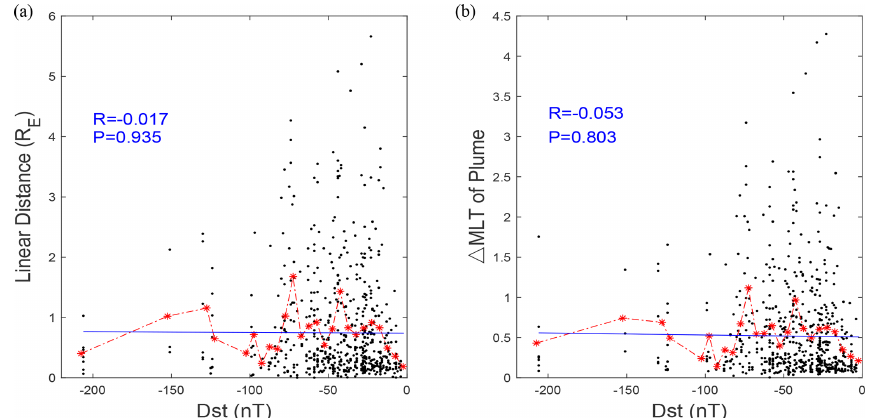
Figure 2. (a) The widths of plumes as a function of Dst values are represented by solid black dots, where the width expresses the Cartesian distance between the two ends (the entrance and exit) of the VAP-A orbit where the plume is detected. The linear fitting of the plasmaspheric plume’s averaged widths in each step of the 5nT range (red asterisk points) is indicated by the blue line. (b) The format is similar to (a) ; however, the (cid:49) MLT of the plasmaspheric plume is adopted to represent the width of the plume. Table 1. The number of events corresponding to different intervals after the minimum Dst. Interval (days)